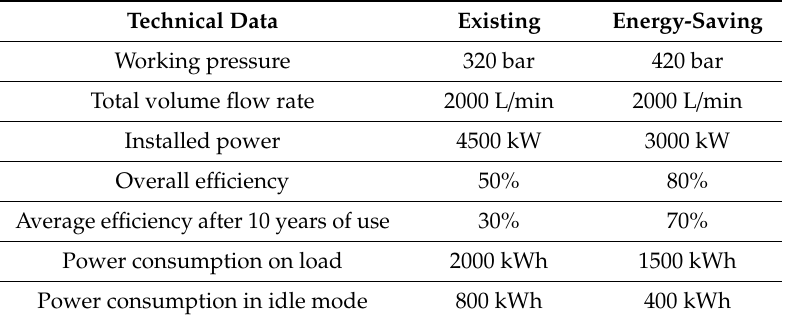
Table 2. Technical data of hydraulic power supply.